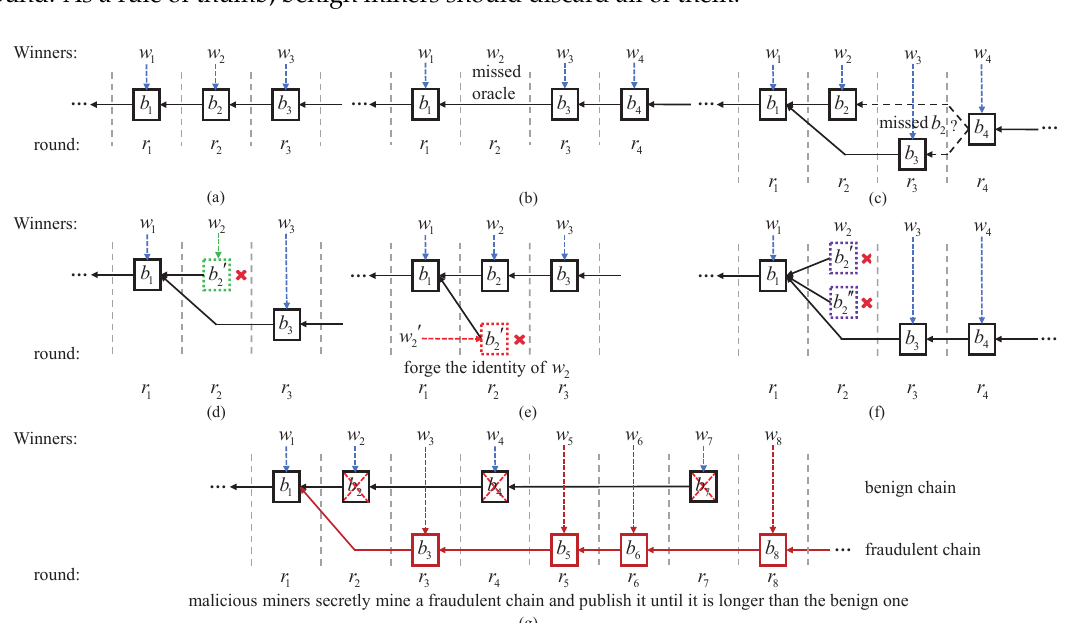
Figure 2. Possible patterns of blockchain evolution based on the satellite-aided consensus. ( a ) Regular extension. ( b ) Oracle missing. ( c ) Block missing. ( d ) Invalid blocks. ( e ) Fraud identity. ( f ) Multi-block in one round. ( g ) Alternative history